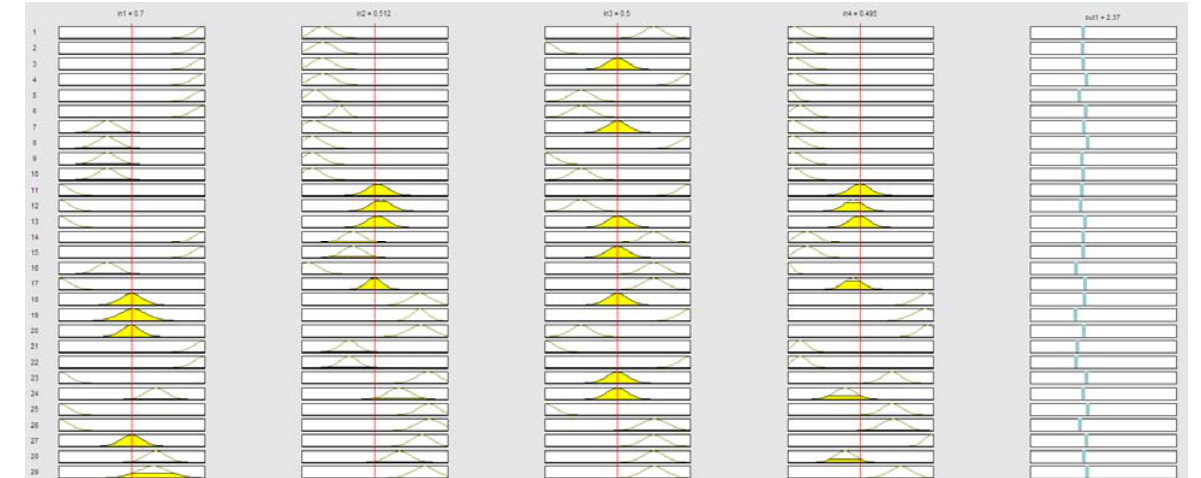
Figure 20. Rules provided by the ANFIS for operation tasks